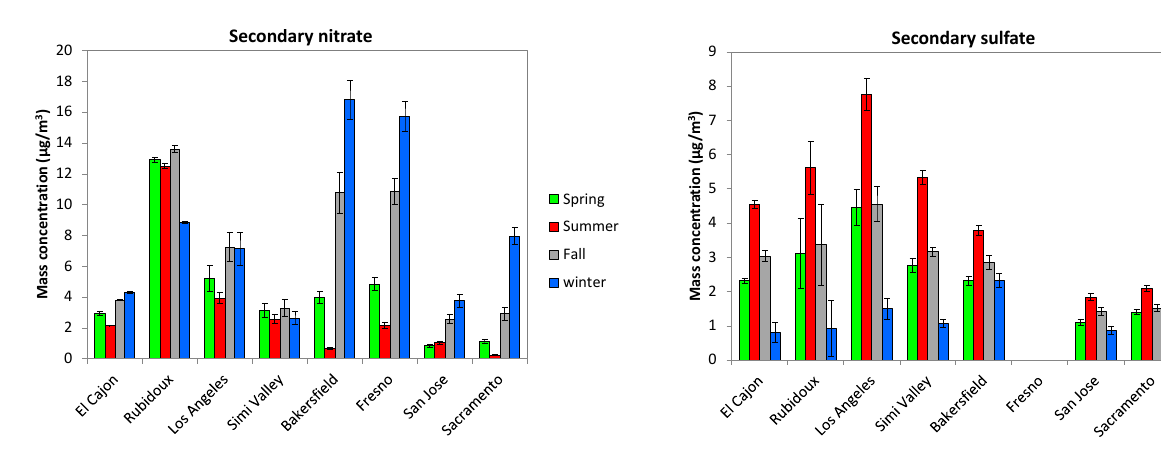
Figure 4. Seasonal average source contribution (µg/m 3 ) of secondary ammonium sulfate to ambient PM 2.5 , by site. Error bars correspond to one standard error.